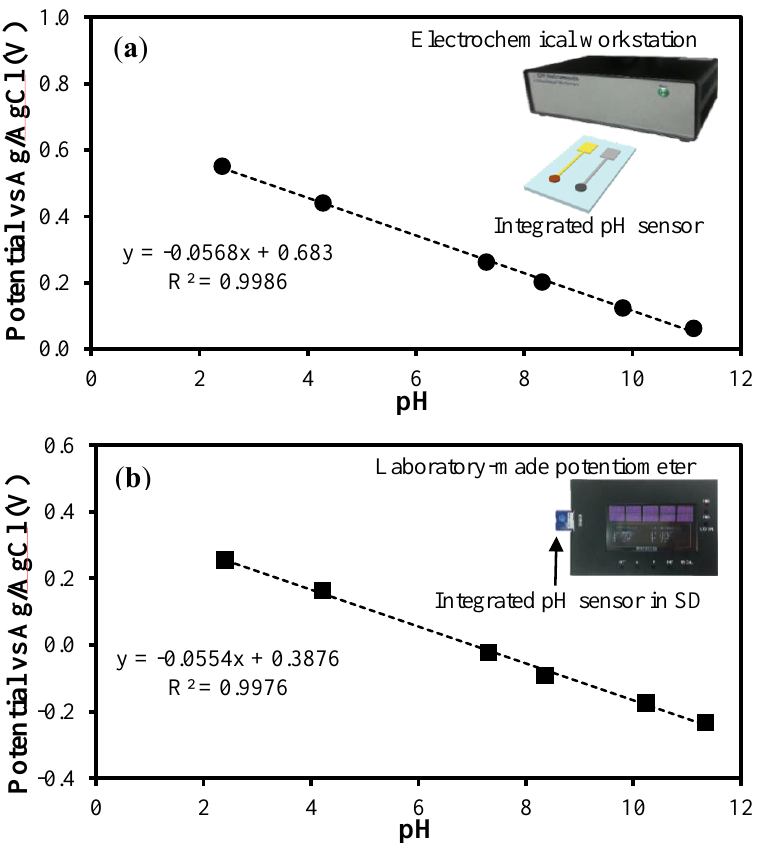
Figure 9. The integrated pH sensors were evaluated in various solutions of different pH values. ( a ) The integrated pH sensors with an electrochemical workstation, and ( b ) the integrated pH sensors packaged in an SD card with the laboratory-made potentiometer were used for potential measurements. Each inset indicates the experimental setup used for the test. (The error bars were not shown as the difference in the potentials was smaller than 10 mV for both ( a ) and ( b